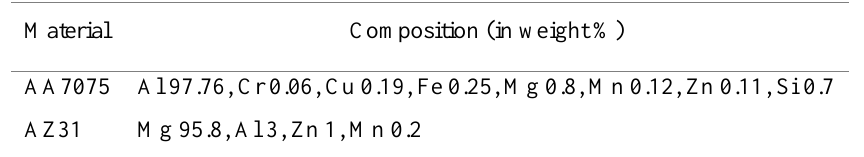
Table 1. Chemical composition of the base